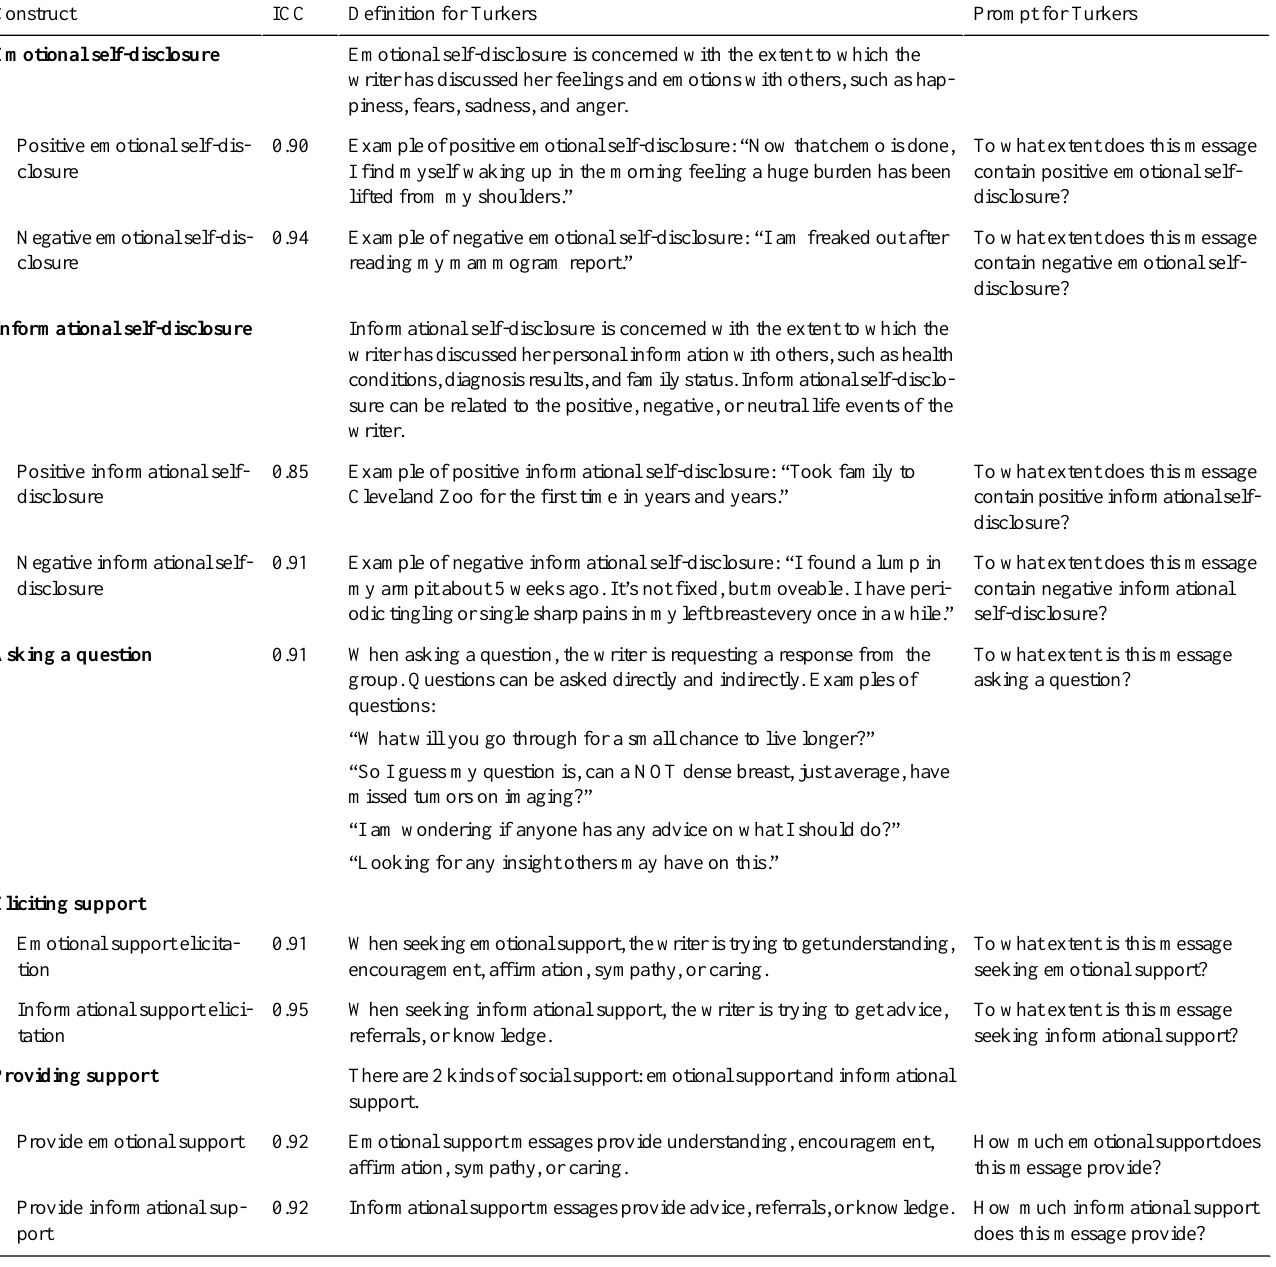
Prompt for TurkersDefinition for TurkersICCConstruct